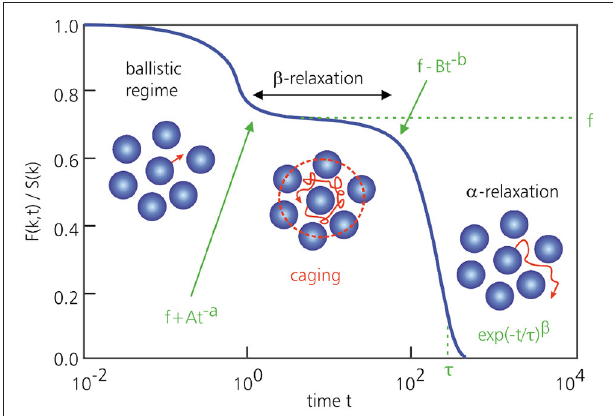
FIGURE 7 | Typical MCT prediction for F ( k , t ) of a supercooled liquid as a function of time, for a wavenumber k = k 0 that corresponds to the first peak of the static structure factor. At very short times, particles undergo ballistic motion. At intermediate times, particles become transiently trapped in cages ( β -relaxation) and F ( k , t ) correspondingly remains approximately constant. Only at sufficiently long times will particles break free and full relaxation takes place ( α